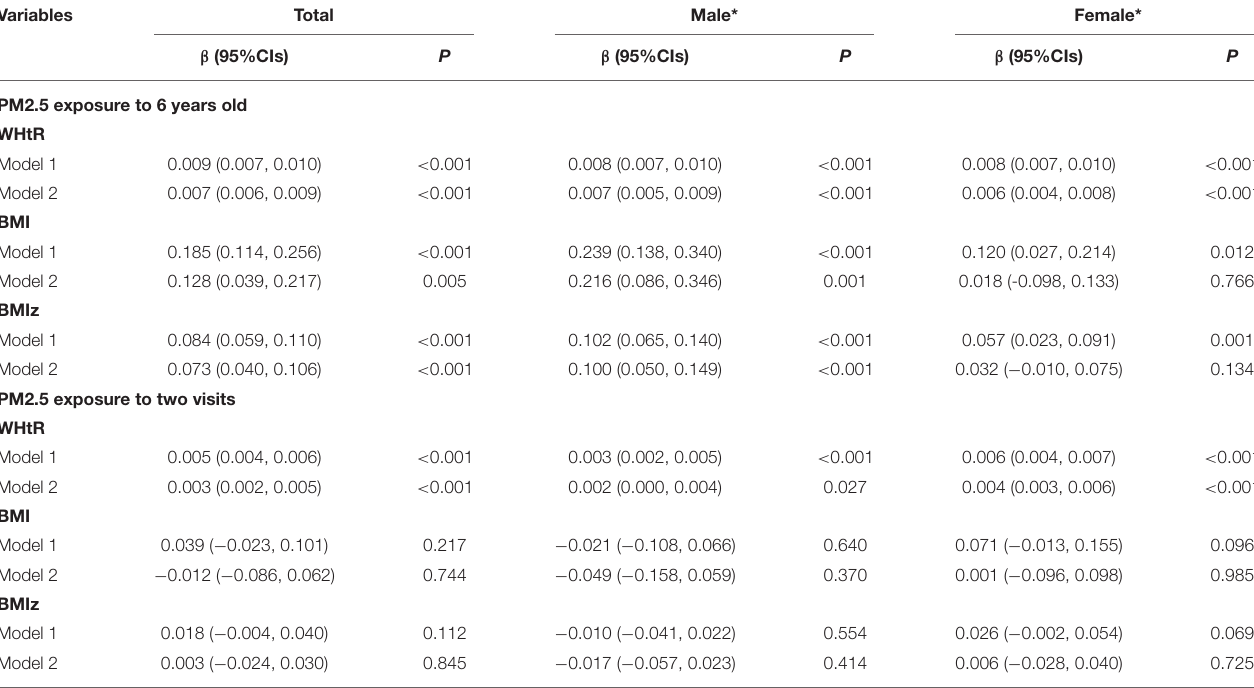
TABLE 2 | The PM2.5 exposure (per 5 µ g/m 3 ) on the growth curve of obesity indexes. Variables